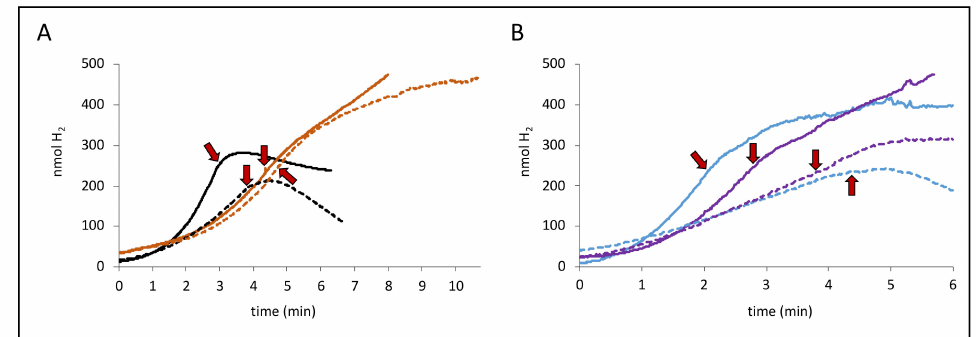
Figure 2. Di ff erent degrees of inhibition by protonophore carbonyl cyanide m -chlorophenyl-hydrazone (CCCP). Panel A shows H 2 production from the strains MC4100 (parental, black curves) and CP734 ( ∆ hyaB ∆ hybC , orange curves) while panel B shows the strains CP630 ( ∆ hyaB , blue curves) and CP631 ( ∆ hybC , purple curves) after addition of either 14 mM glucose (dashed lines) or 50 mM formate (solid lines). When H 2 production was linear, a final concentration of 100 µ M CCCP was added to the reaction vessel, as indicated by the red arrows.